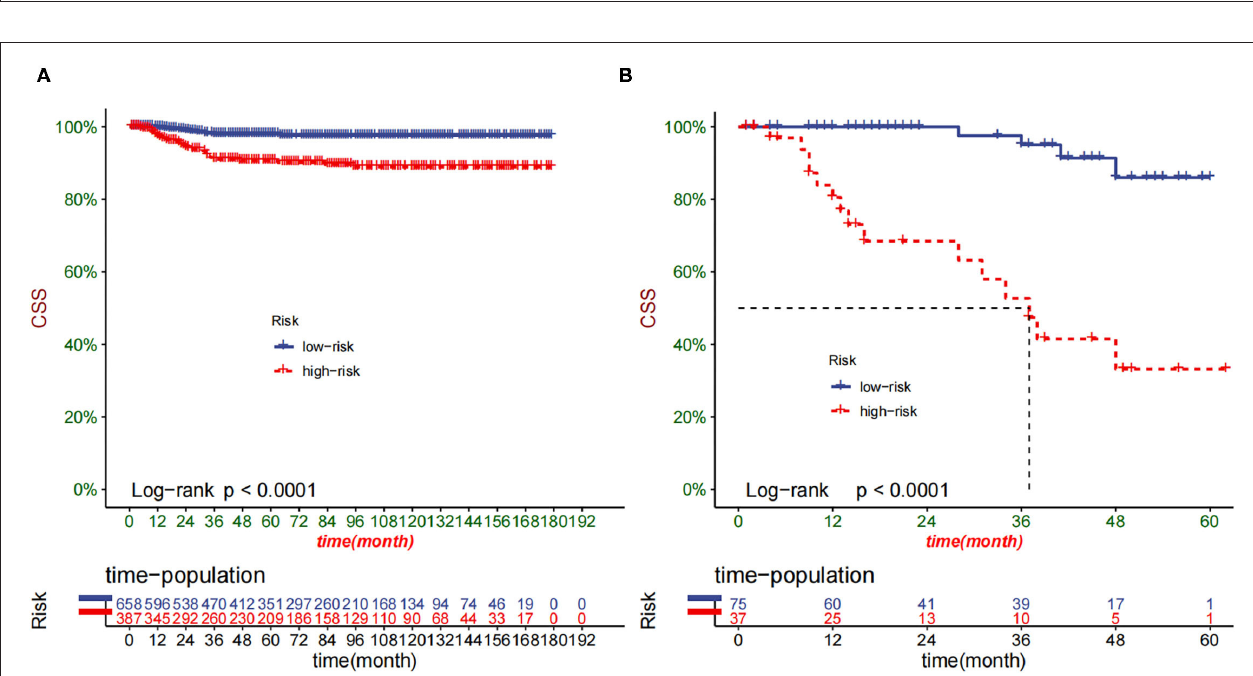
FIGURE 8 | Kaplan–Meier curves of CSS for children in the low- and high-risk groups in the training set (A) and validation set (B) .